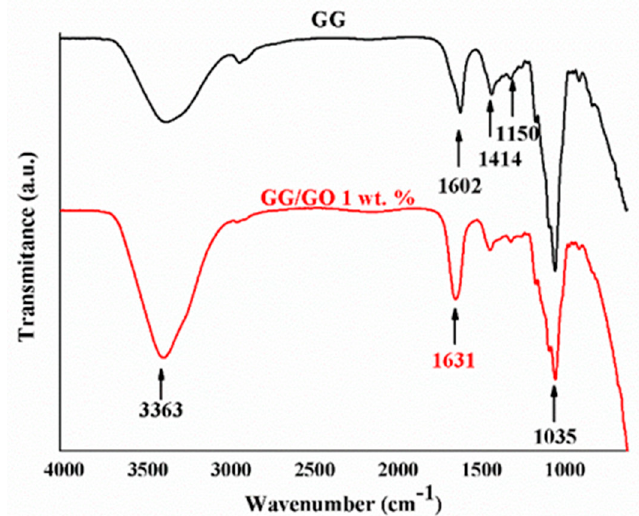
Figure 3. FTIR spectra of GG and GG/GO hydrogel composite beads.